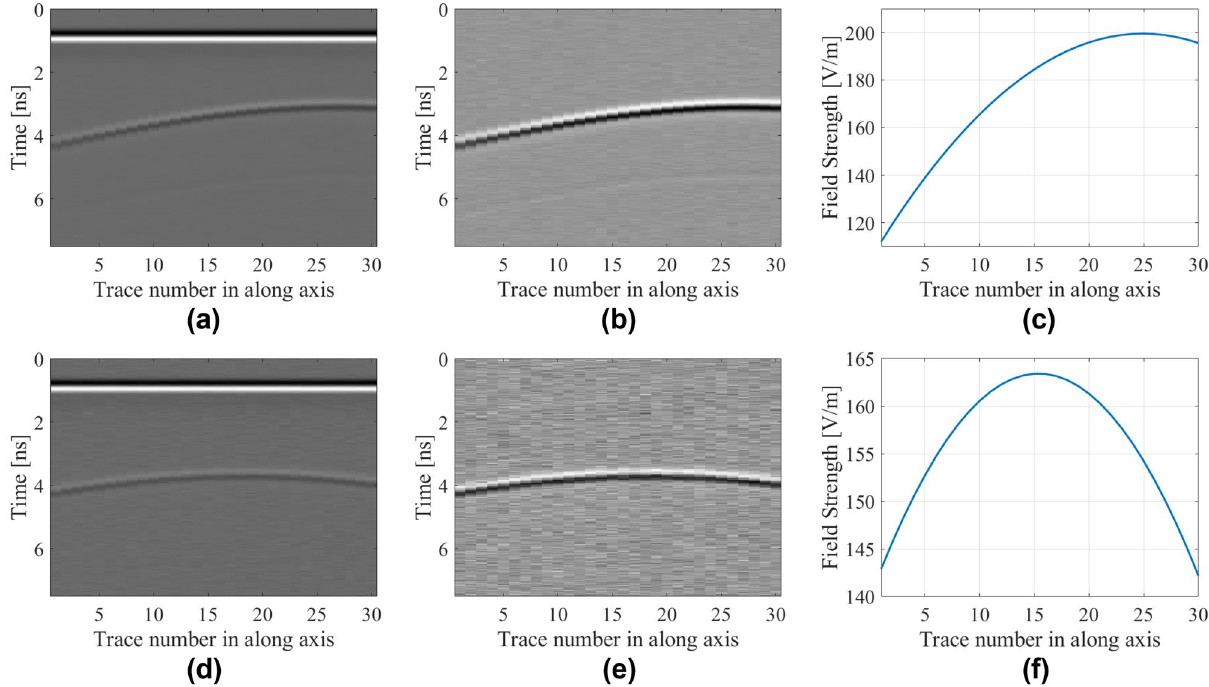
Figure 13. Raw and pre-processed B-scan data along with their extracted hyperbolic patterns for selected samples from the test scenarios including noise. The SNR for first scenario is 30 dB, whereas the objective parameters are D = 212 mm, P = 318 mm, and R = 19 mm: ( a ) raw B-scan image, ( b ) B-scan image with removed background reflections, ( c ) extracted hyperbolic pattern. The SNR for the second scenario is 20 dB, D = 259 mm, P = 231 mm, and R = 12 mm: ( d ) raw B-scan image, ( e ) B-scan image with removed background reflections, ( f ) extracted hyperbolic pattern.